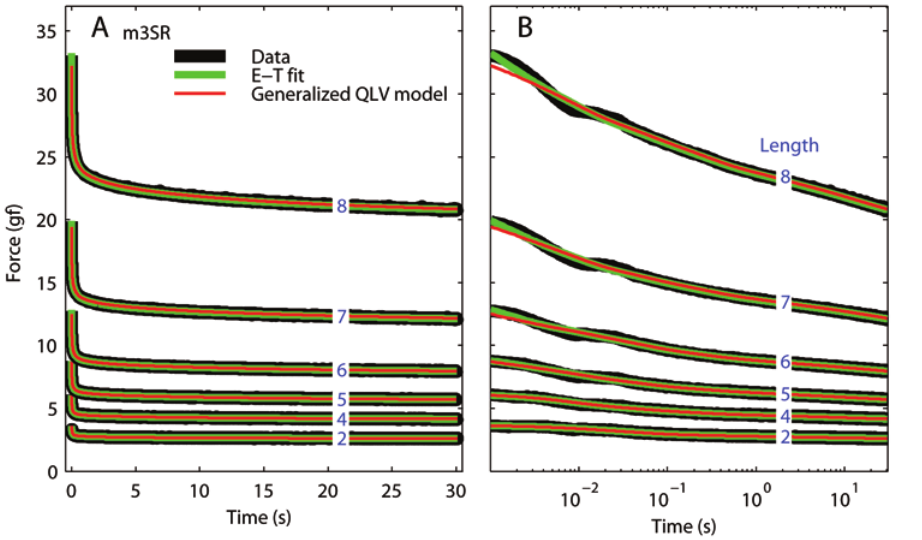
Figure 2. Relaxation responses and generalized QLV model fits. A : Data (black), Emri-Tschoegl fit to the relaxation response (green), and force predicted by the generalized QLV model using the parameters derived analytically from the E-T fit (red). Six different steps are shown (blue numbers are the final lengths in mm), from the superior rectus in m3. B : Same as A, but using a logarithmically spaced abscissa to improve visualization of the force at short